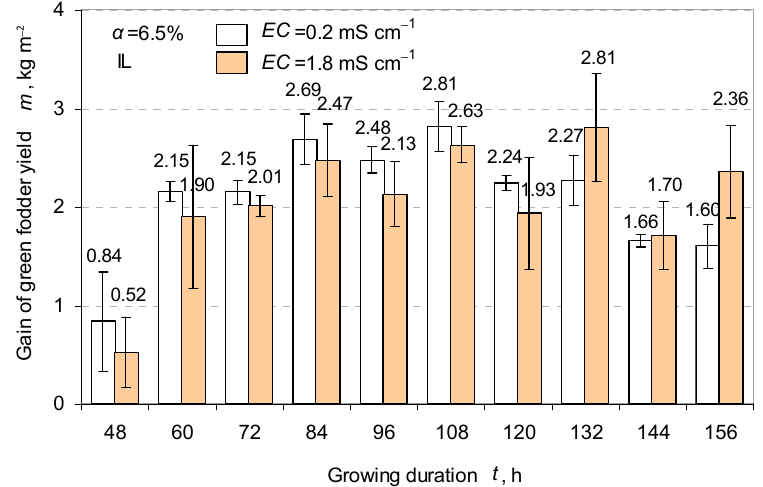
Figure 8. Variation in mass gain of fodder during growing period using indoor lighting. Each vertical bar is 95% confidence interval.